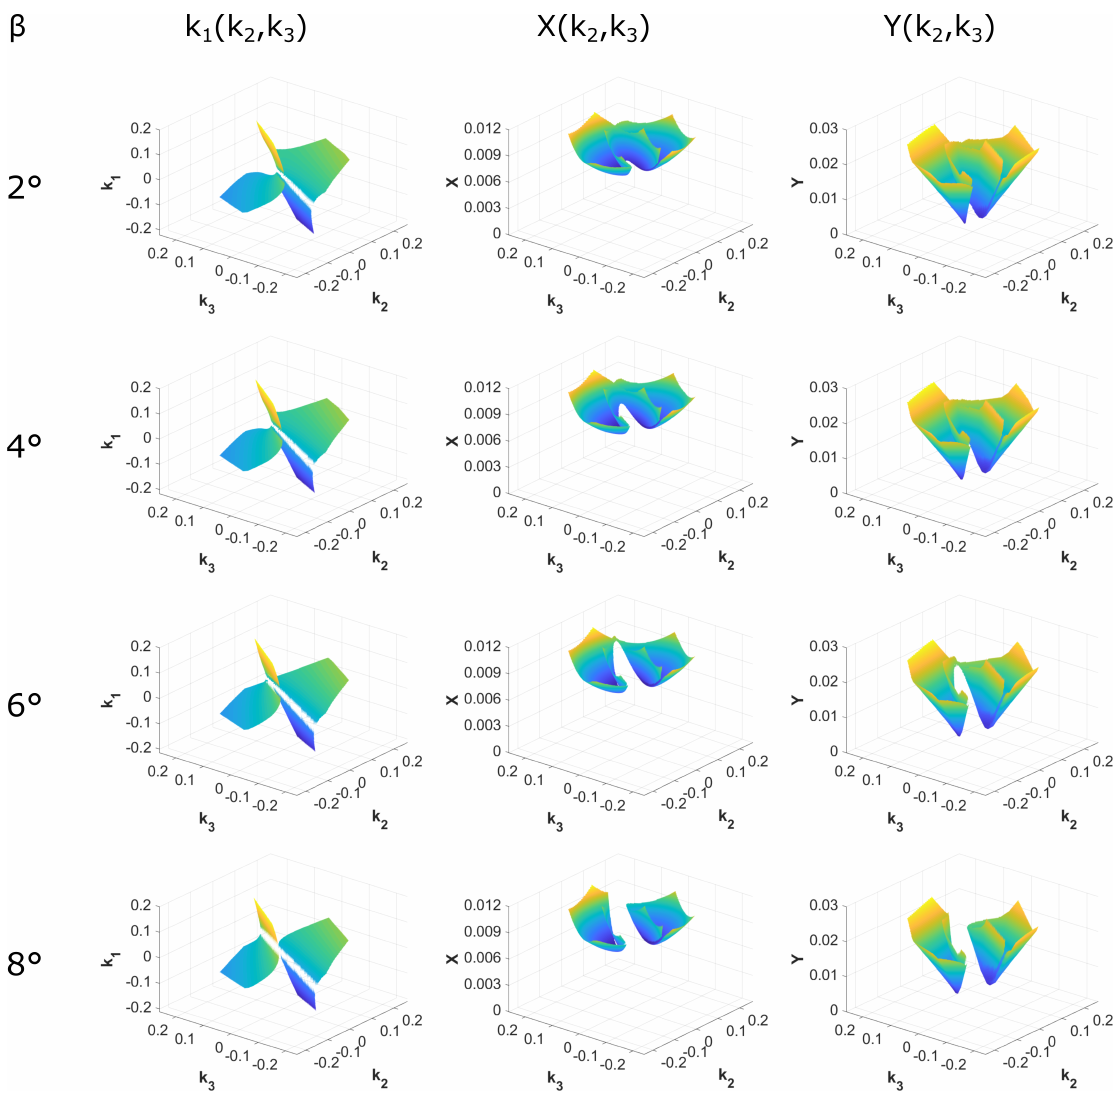
Figure 5. Iso-surfaces of constant yawing moment for an untapered straight wing. For each sideslip angle case presented. Left-hand plots show the values of k to attain the given sideslip angle and the centre and right-hand plots show the results of the optimisation functions X and Y ,